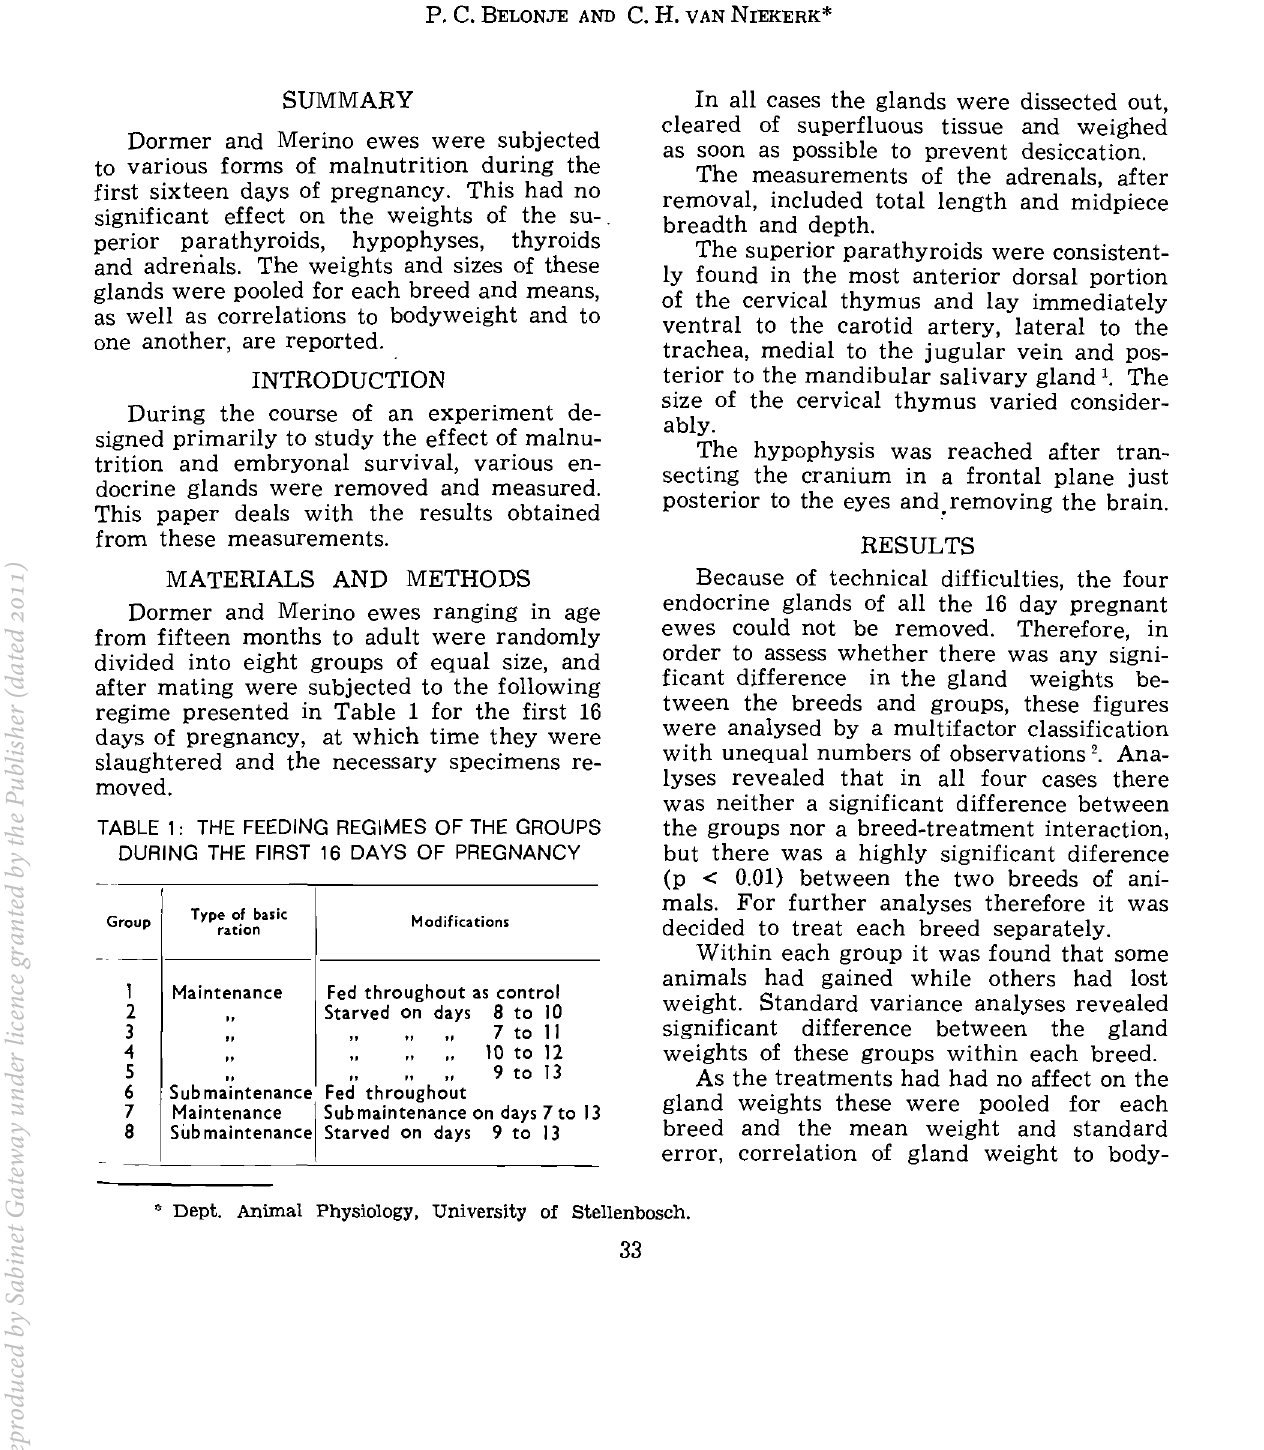
TABLE 1: THE FEEDING REGIMES OF THE GROUPS DURING THE FIRST 16 DAYS OF PREGNANCY